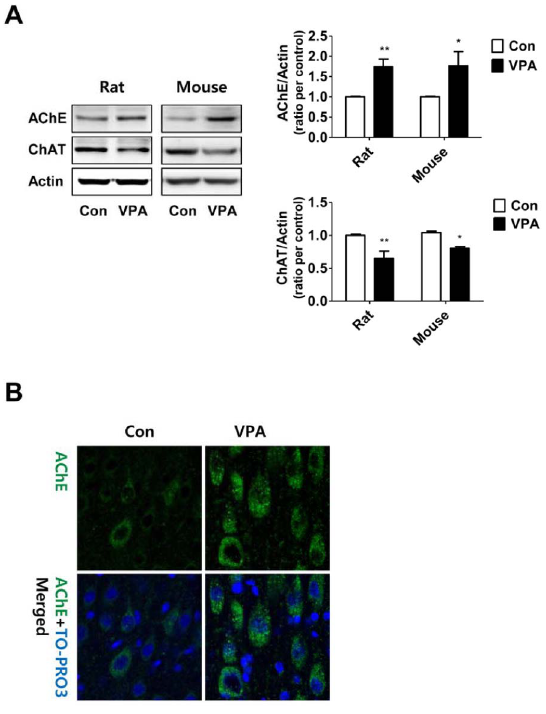
Figure 2. Dysregulation of cholinergic enzyme in the prefrontal cortex region of VPA induced animal model of ASD. Expression level of acetylcholinesterase and choline acetyltransferase was mea- sured using Western blot (A), and acetylcholinesterase was also measured using immunohistochemistry (B) in the prefrontal cortex at post natal day 28. (A) Prenatally VPA-exposed SD rats (400 mg/kg) and ICR mice (300 mg/kg) showed increased acetylcholinesterase (AChE) but decreased choline acetyltransferase (ChAT); left panel rat (N=6), right panel mouse (N=4). Data are expressed as the mean 6 S.E.M. *, **, p , 0.05 and p , 0.01 vs. control. (B) Immunohistochemical staining against acetylcholinesterase (green) in prefrontal cortex region from SD rat exposed to VPA at prenatal period. Nucleus was counter-stained with TO-PRO3 (blue).